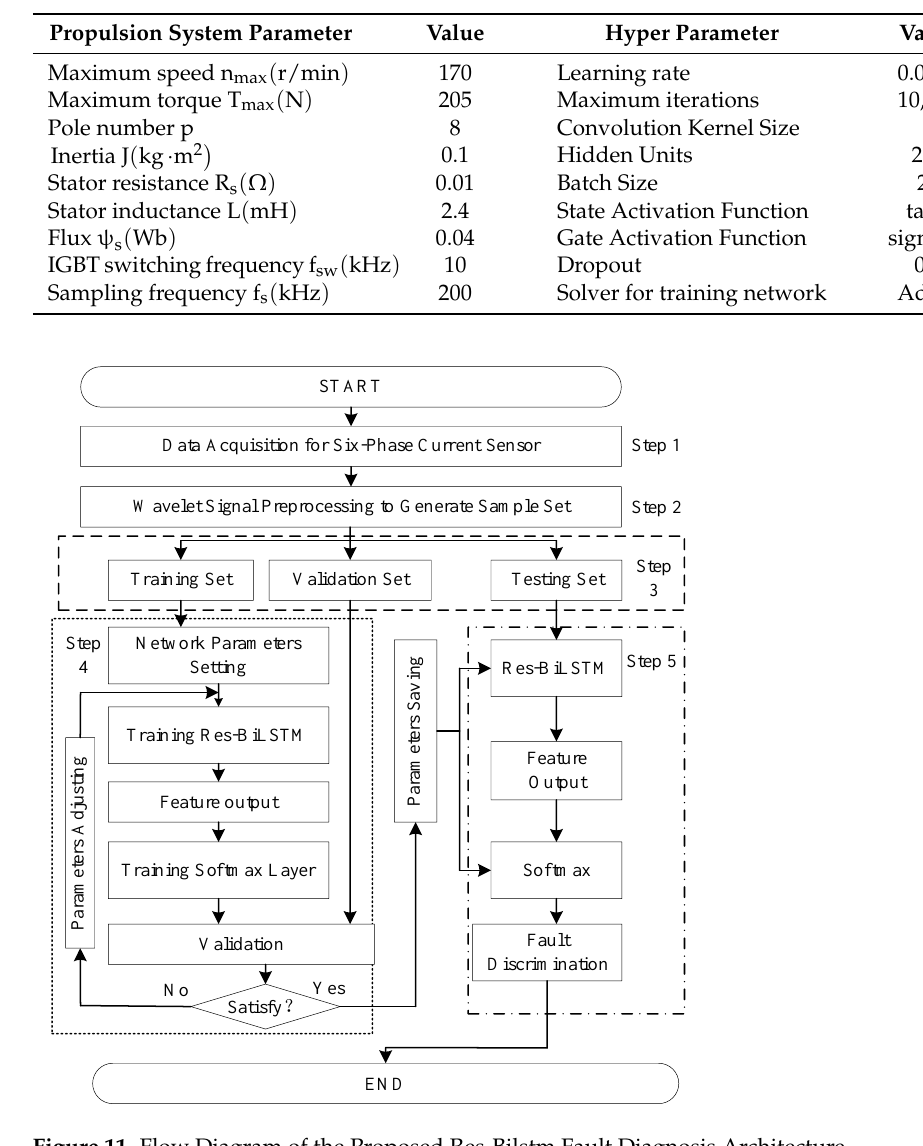
Table 2. Parameters for Propulsion System and Hyper Parameters for Res-BiLSTM.